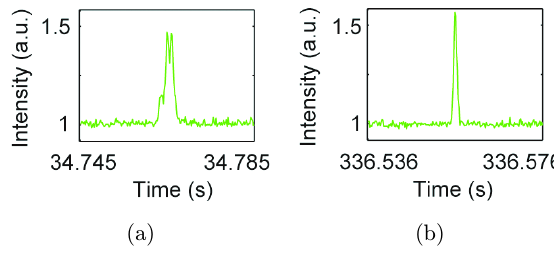
Fig. 9. Representative IVFC pro¯les of a CTC cluster (a) and single CTC